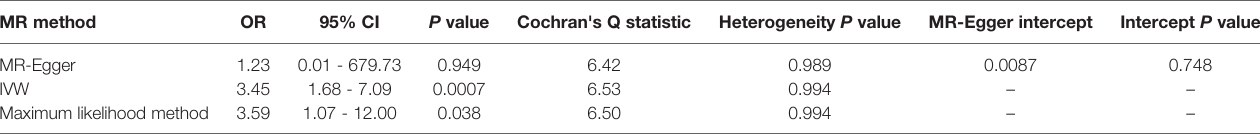
TABLE 2 | MR estimates from each method of the causal effect of snoring on